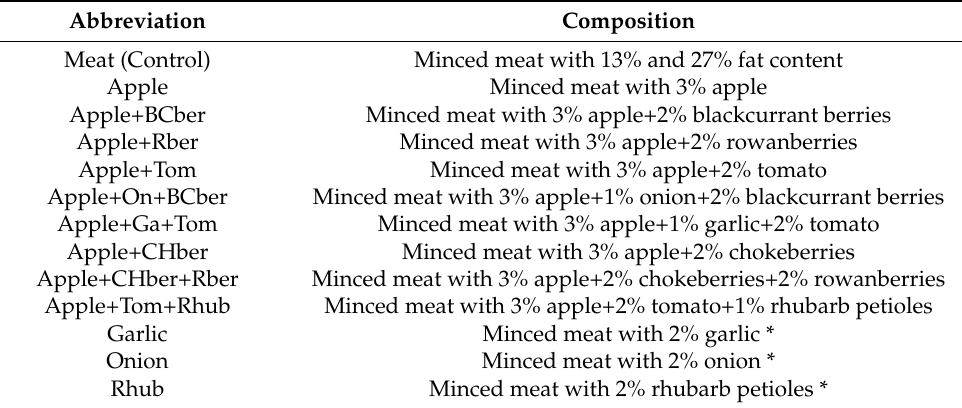
Table 1. Description of the samples used in